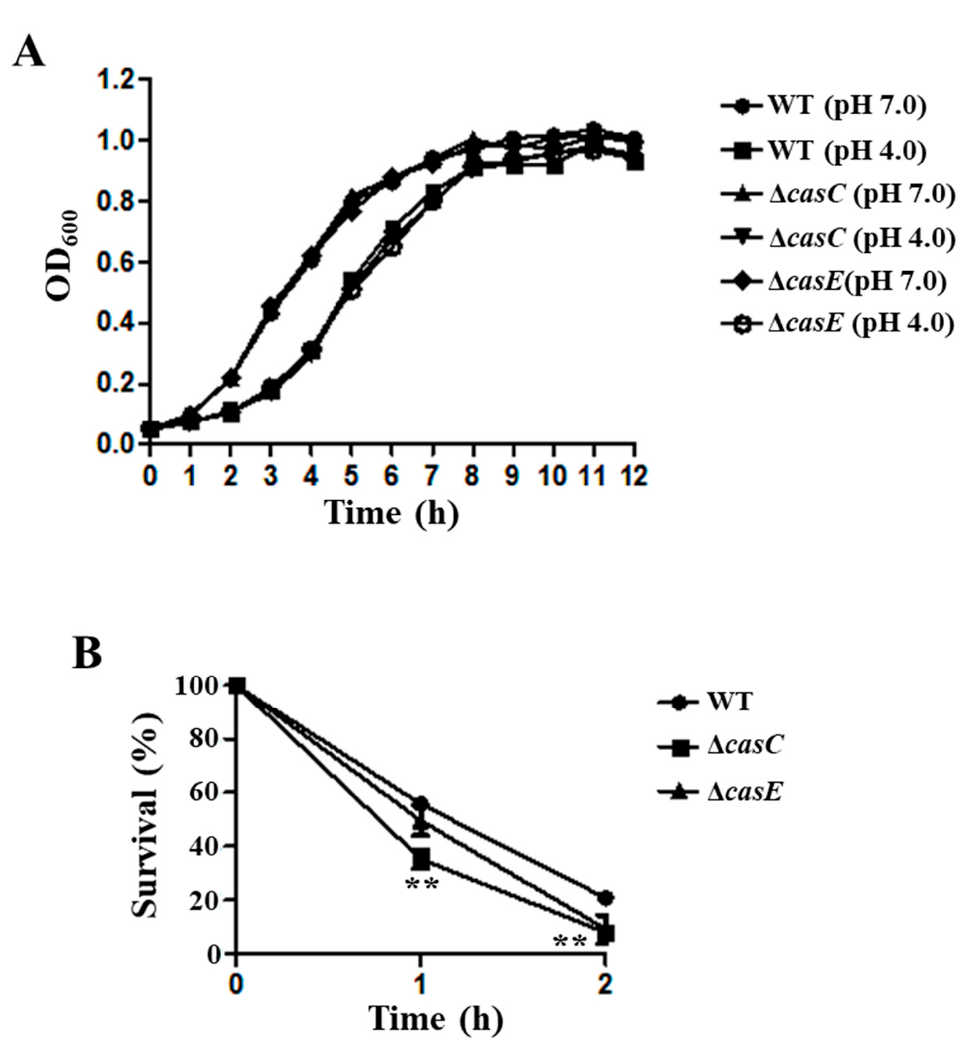
Figure 6. CasC and CasE were involved in the acid resistance of S . Derby. ( A ) Growth curves of WT, ∆ casC , and ∆ casE in LB medium at pH 4.0 and pH 7.0. ( B ) Survival ability of WT, ∆ casC , and ∆ casE at pH 4.0. All the experiments were repeated three times. **, p ≤ 0.01 (Student’s t -test).